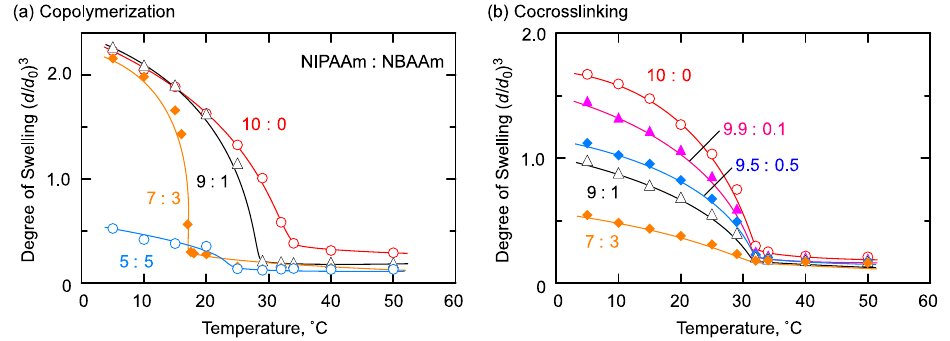
Figure 5. Swelling behavior of NIPAAm/NBAAm ( a ) copolymerization and ( b ) co-crosslinking gels. Preparation condition of copolymerization gels: [NIPAAm] + [NBAAm] = 1400 mM, [BIS] = 48.6